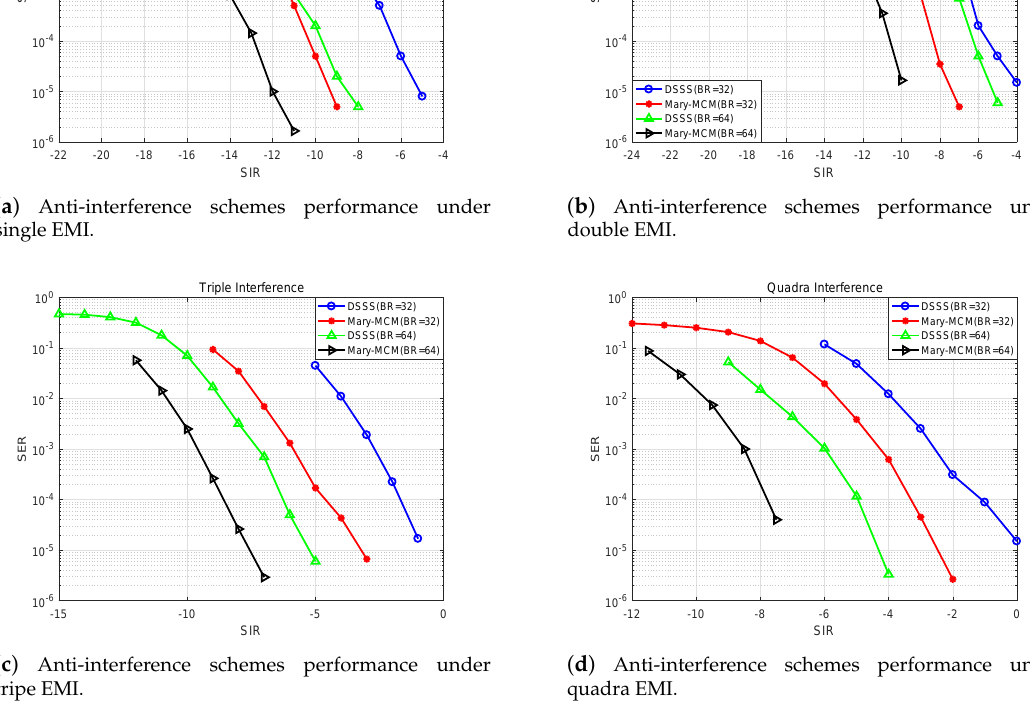
Figure 18. Anti-interference schemes performance under different spreading